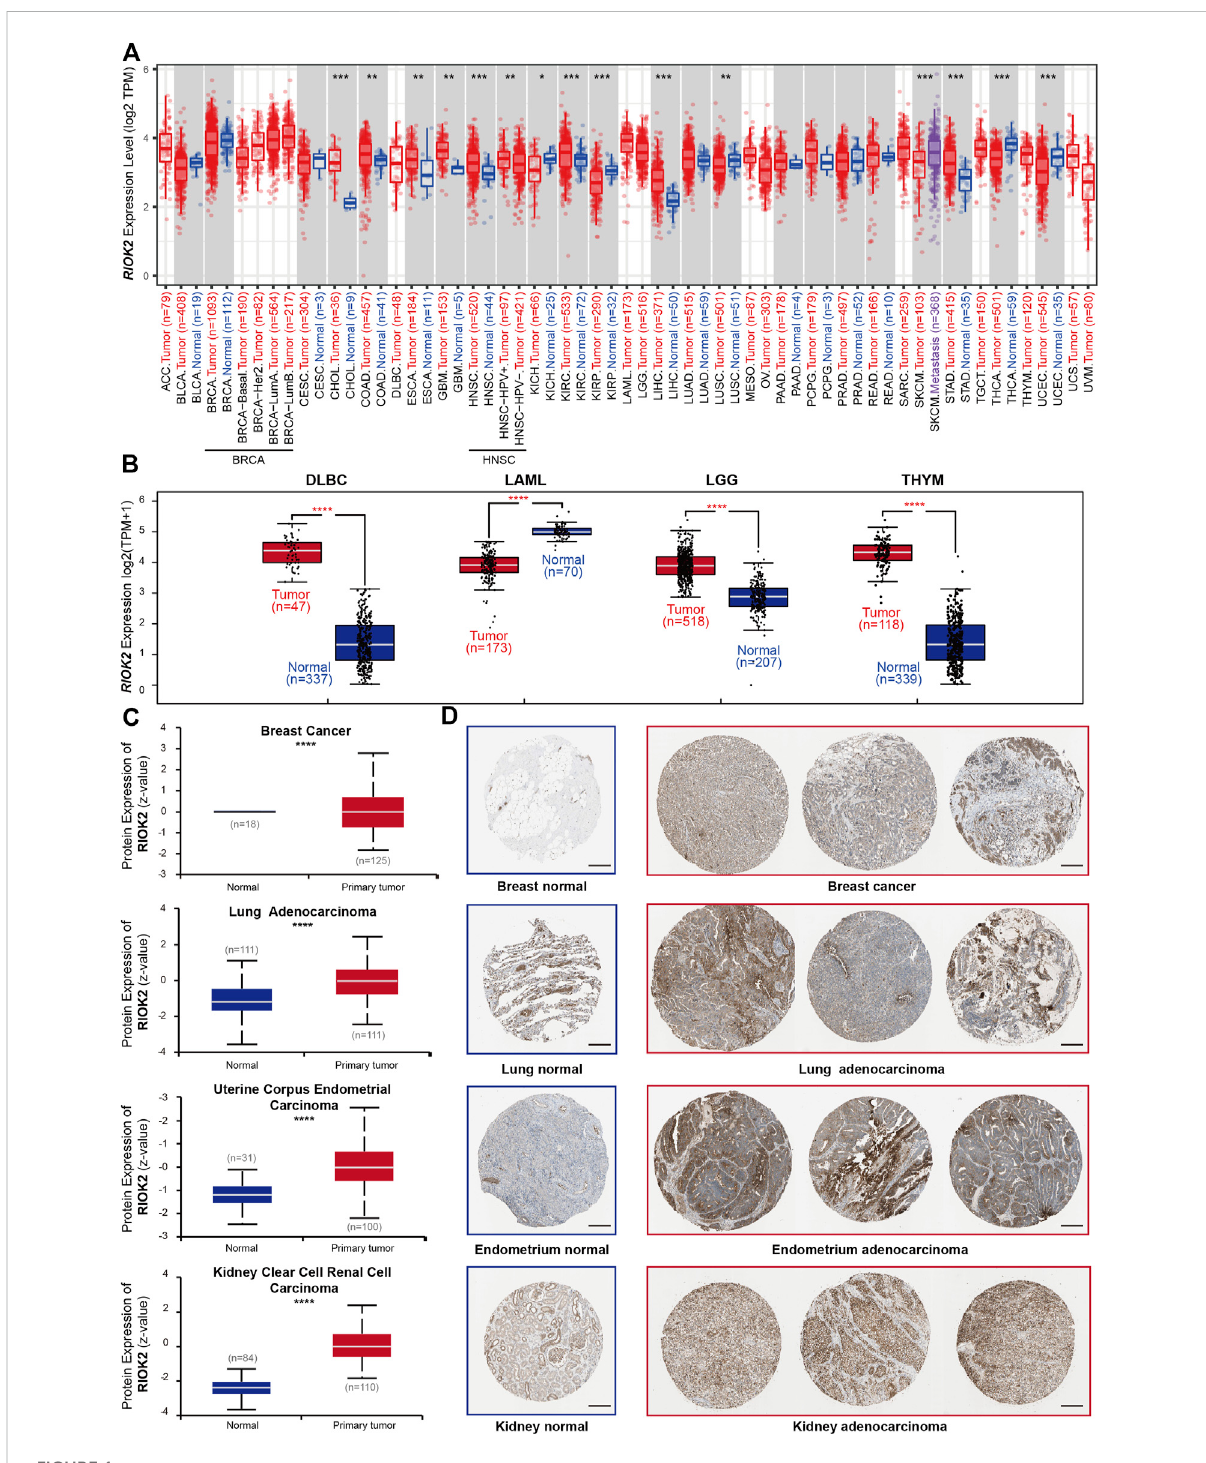
FIGURE 1 Expression level of RIOK2 gene indifferenttumors and normal tissues. The distribution ofRIOK2 expression levels isshown using box plots. We identi fi ed RIOK2 mRNA (A,B) and protein (C) that were upregulated or downregulated in tumors (red) compared to healthy tissues (blue) for each cancer type, as displayed in gray columns where control data were available. (D) Representative images of immunohistochemistry staining for RIOK2 protein constructed from four cancer types. Scale bars: 200 μ m. Statistical signi fi cance, as computed using the Wilcoxon test, is annotated by the number of stars (* p < 0.05, ** p < 0.01, *** p < 0.001, **** p <